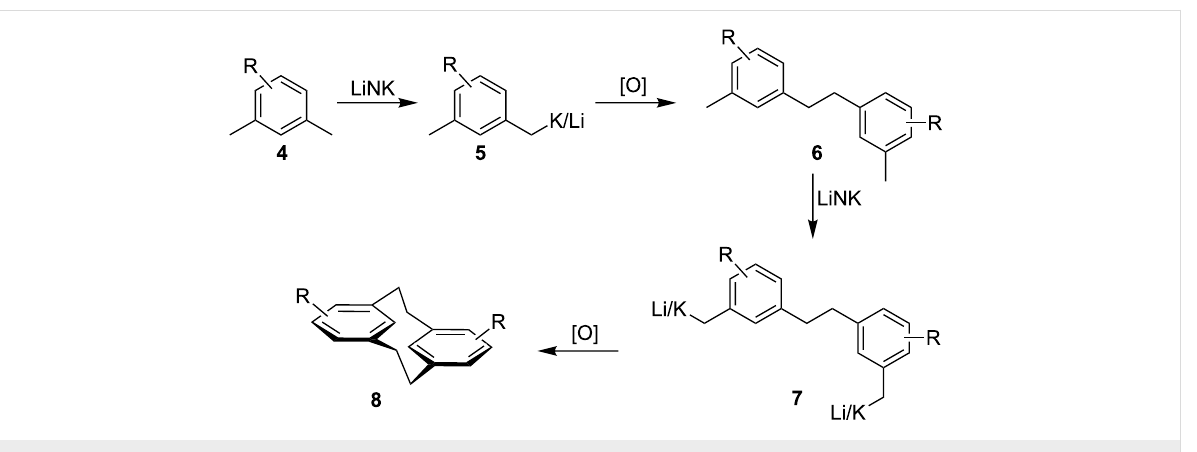
Scheme 2: Iterative LiNK/oxidative coupling synthesis of [2.2]metacyclophanes.